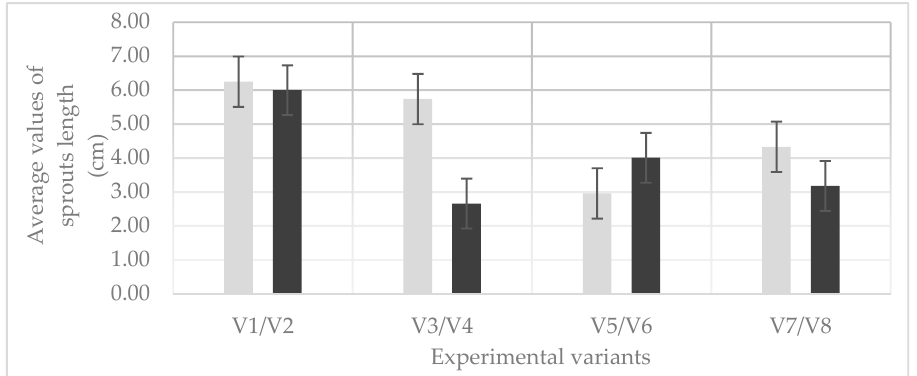
Figure 1. The medium values of Lepidium sativum L. sprout lengths on gauze (V1 control, illuminated with sunlight; V3, illuminated with white LED; V5, illuminated with blue LED; V7, illuminated with red LED experimental variant) or biochar (V2 control, illuminated with sunlight; V4, illuminated white LED; V6, illuminated with blue LED; and V8, illuminated with red LED experimental variant). Data acquired from the experiment were statistically investigated and were expressed as the mean ± SD (standard deviation). Bars are one standard deviation.